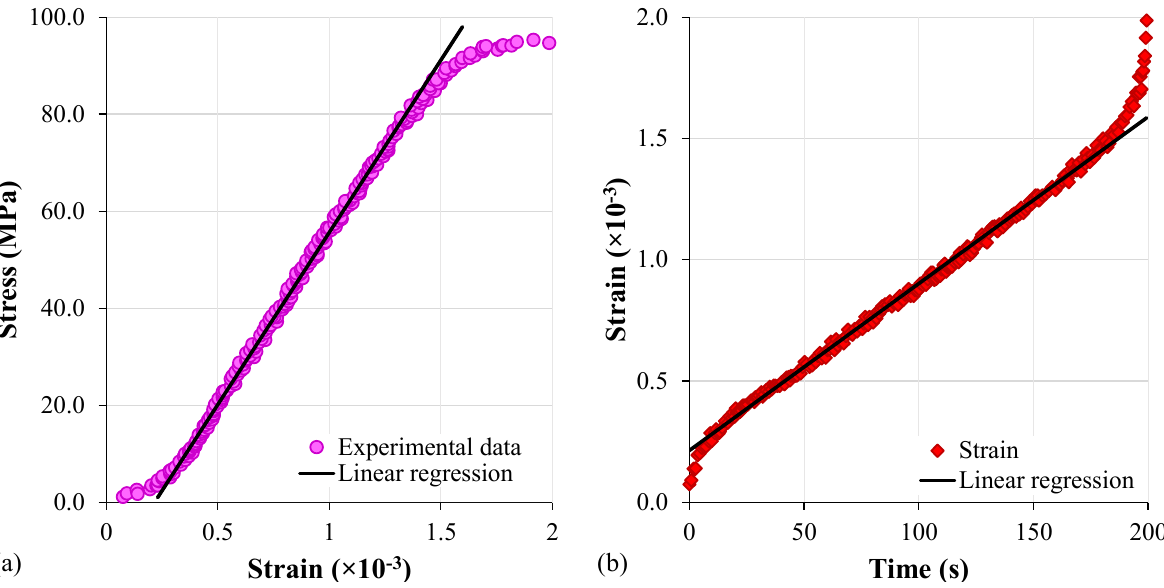
Figure 7. ( a ) The axial stress versus the axial strain for the intact prismatic marble specimen. ( b ) The temporal evolution of the strain for the intact prismatic marble specimen.